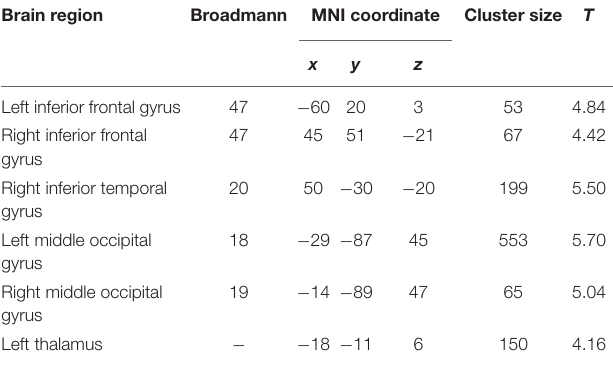
TABLE 5 | Gray matter volume differences between the posttreatment and baseline in the patient group. Brain